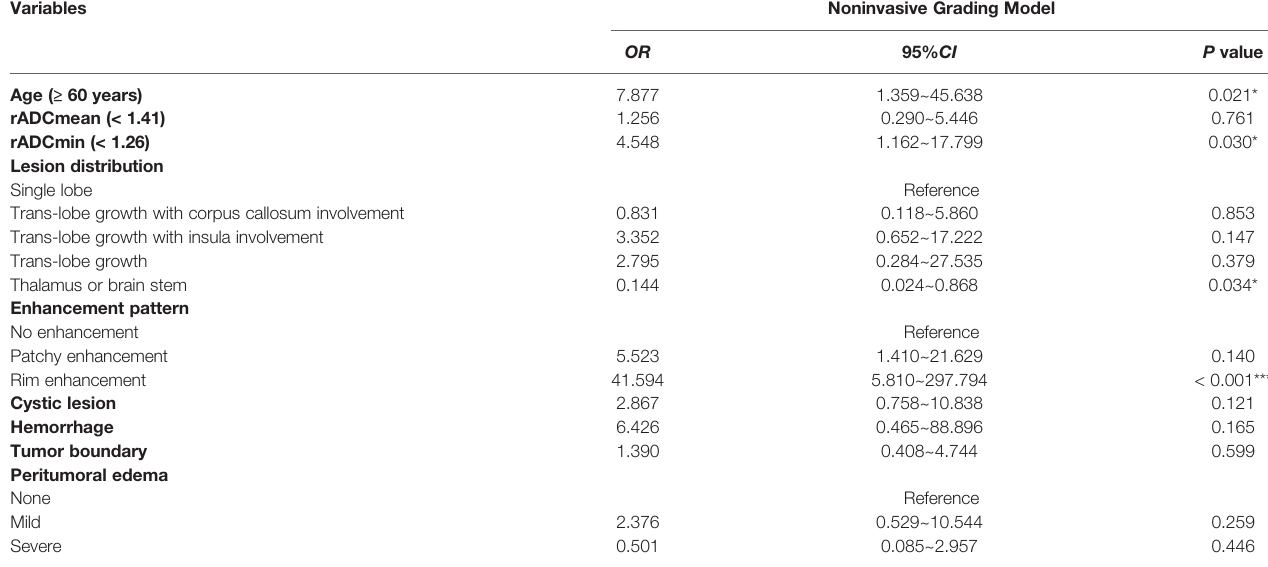
TABLE 6 | Multivariate logistic regression analysis of glioma grades.